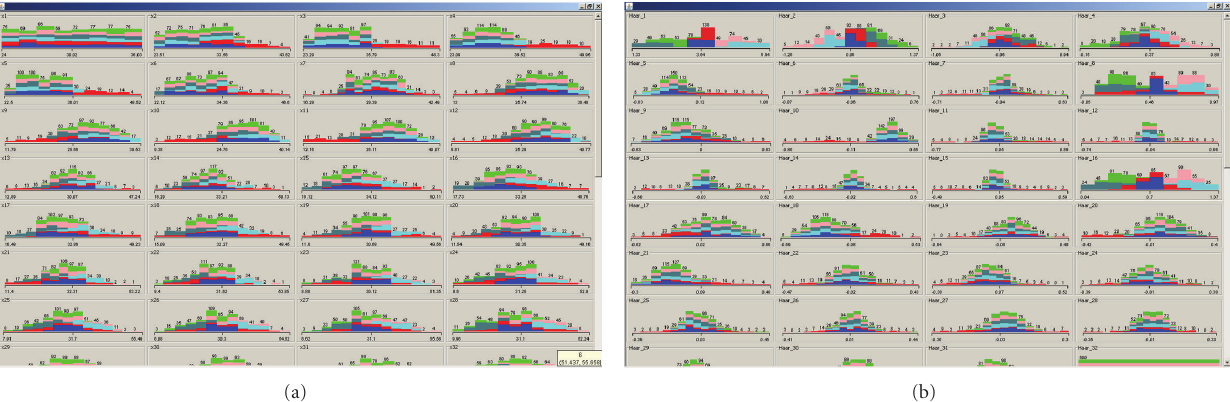
Figure 9: (a) Attributes of the a voice time series; (b) transformed attributes called Haar coe ffi cient of the wavelet representation of the time series.